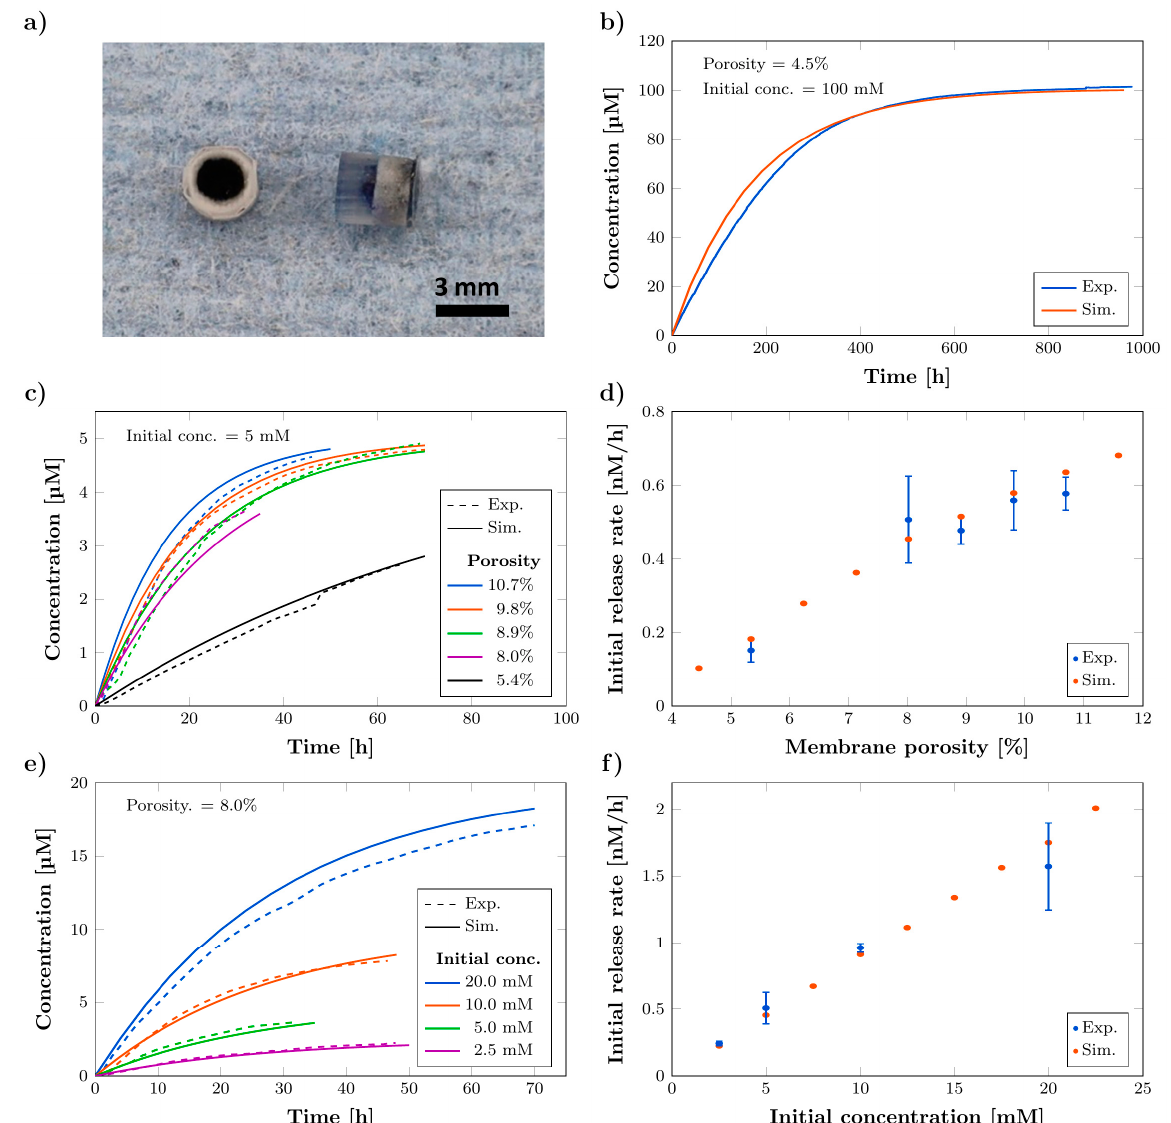
Figure 4. Characterization of release kinetics from standard-sized reservoir-based drug delivery systems (rDDS) with experimental results (Exp.) compared to simulation data (Sim.). ( a ) Photograph of top and side view of rDDS loaded with methylene blue (MB) solution. ( b ) Concentration curve showing a long-term release from rDDS with 4.5% membrane porosity and initial concentration inside the reservoir of 100 mM. ( c ) Concentration curves for varying membrane porosities (5 mM initial concentration) and ( d ) respective initial release rates calculated as mean between 0–20 h. ( e ) Concentration curves for varying initial concentrations (5.4% membrane porosity) and ( f ) respective initial release rates calculated as mean between 0–20 h. All experimental release curves are averages ( n = 3), and error bars represent the standard deviation.